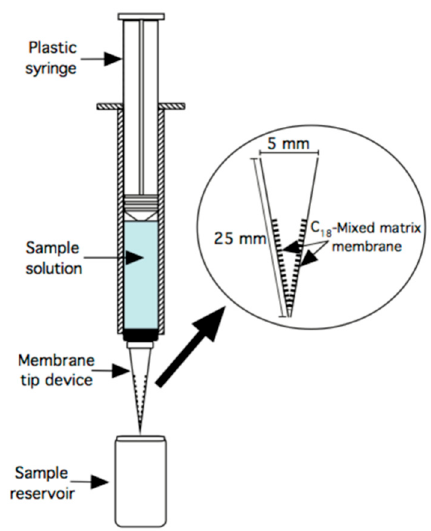
Figure 1. Schematic illustration of the C 18 -mixed matrix membrane tip microextraction setup.